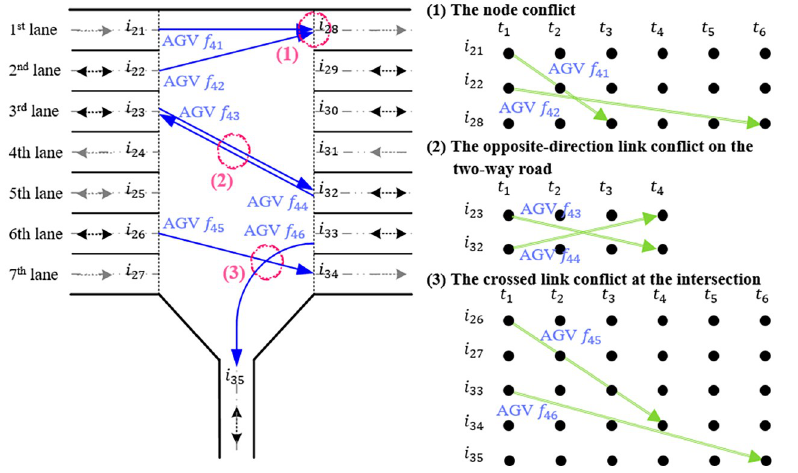
Fig 8. An example of the space-time representation of AGV conflicts at one